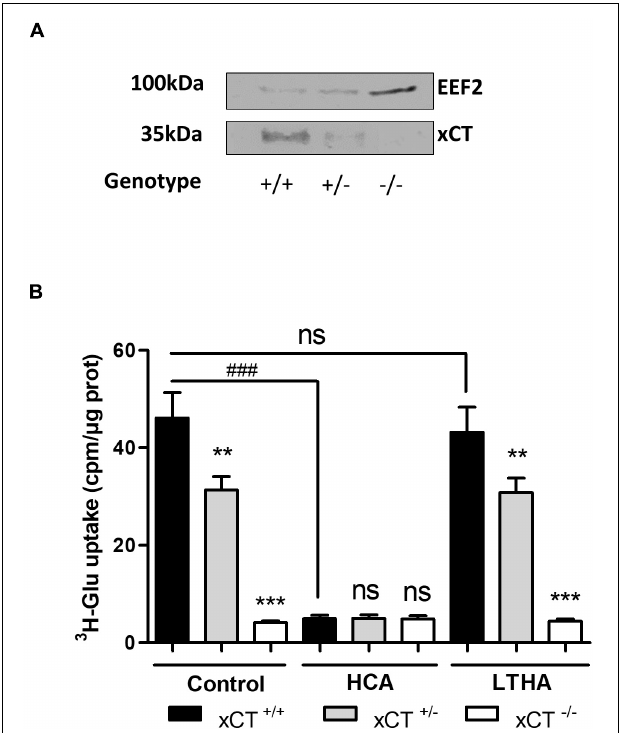
FIGURE 4 | xCT expression and system x c − -dependent [ 3 H]- L -glutamate uptake using spinal cord synaptosome preparations. xCT expression (A) and [ 3 H]- L -glutamate uptake (B) in crude synaptosomes prepared from freshly isolated spinal cord samples. Tissues were obtained from transgenic xCT + / − and xCT − / − C57BL/6 mice and from wild-type littermates (xCT + / + ). The genetic deletion of xCT was validated by Western blot using a specific antibody against rodent xCT. EEF2 detection was used as a control for sample loading and protein blotting. The blot shown is representative of three independent experiments. Histograms represent the mean with SEM of the uptake capacity from three independent experiments performed in quadruplicate. Statistical analyses were conducted using a one-way ANOVA followed by a Dunnett’s test for multiple comparisons [ns p > 0.05, ** p < 0.01, *** p < 0.001 refer to the comparison between genotypes (vs. xCT + / + ). ns p > 0.05, ### p < 0.001 refers to the comparison within the same